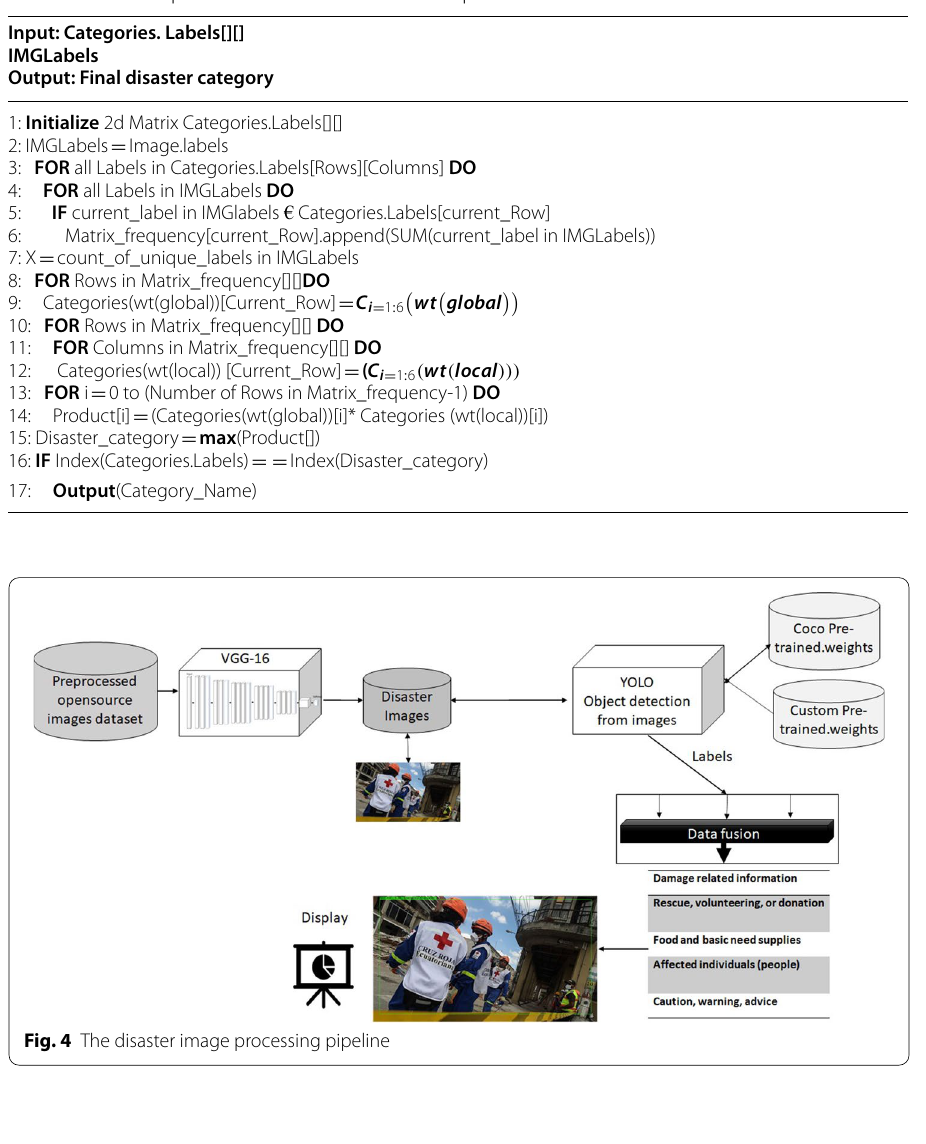
Table 6 Detailed procedure of information fusion process